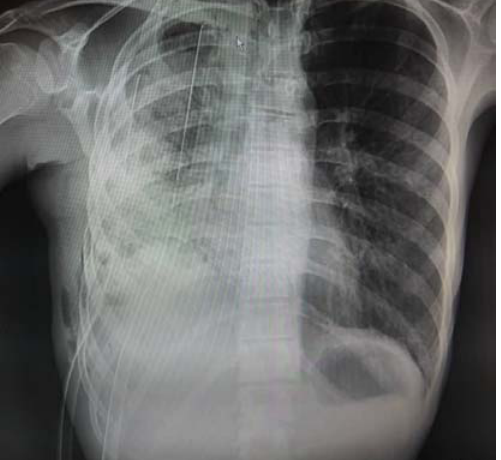
Figure 5. Chest X-ray of patient after